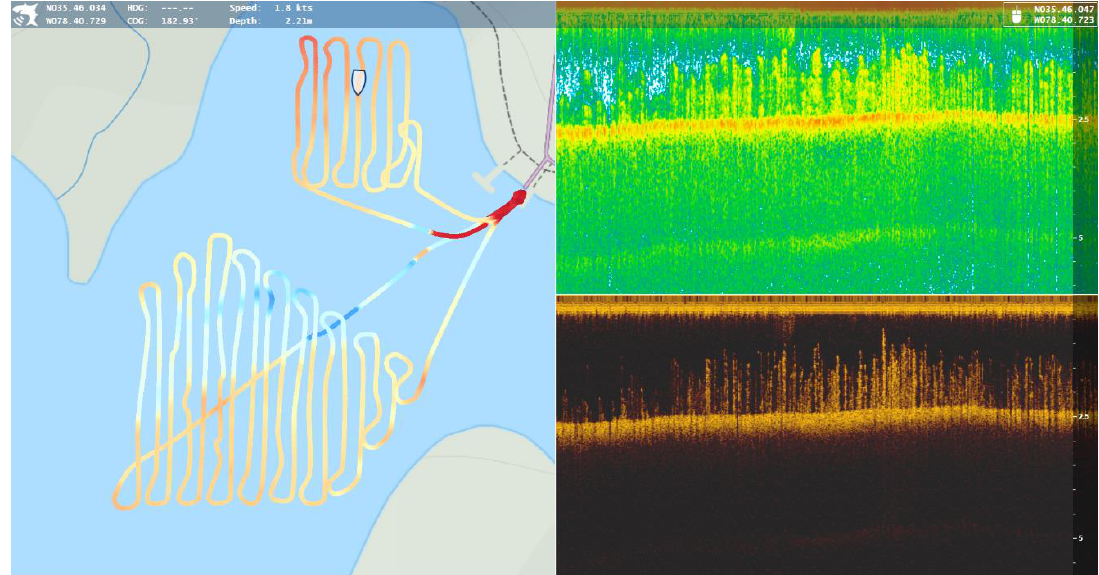
Figure 11. Screenshot from Reefmaster Sonar Viewer software illustrating hydroacoustic imagery acquired on Lake Raleigh: left—map location corresponding with imagery (indicated by boat icon) and traversed path (with increasing depth, path color changes from red to blue); top right—Primary scan sonar; bottom right—DownScan ™ sonar.